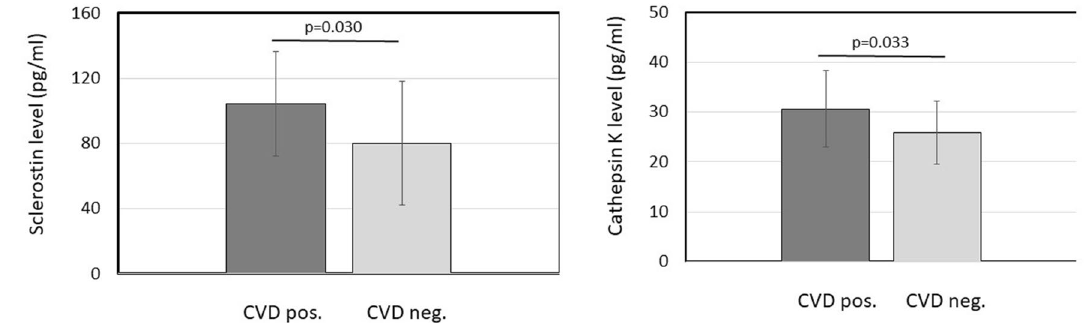
Figure 1. Levels of sclerostin and cathepsin K in arthritis patients with and without cardiovascular (CV) history. Serum concentrations of both primarily bone biomarkers are significantly increased in patients with positive history of CV